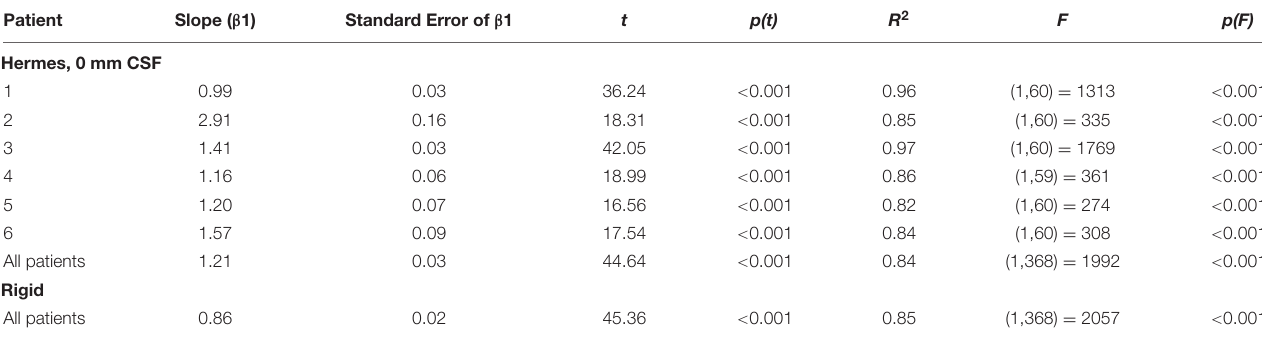
TABLE 3 | Predicting the recorded voltage: linear regression